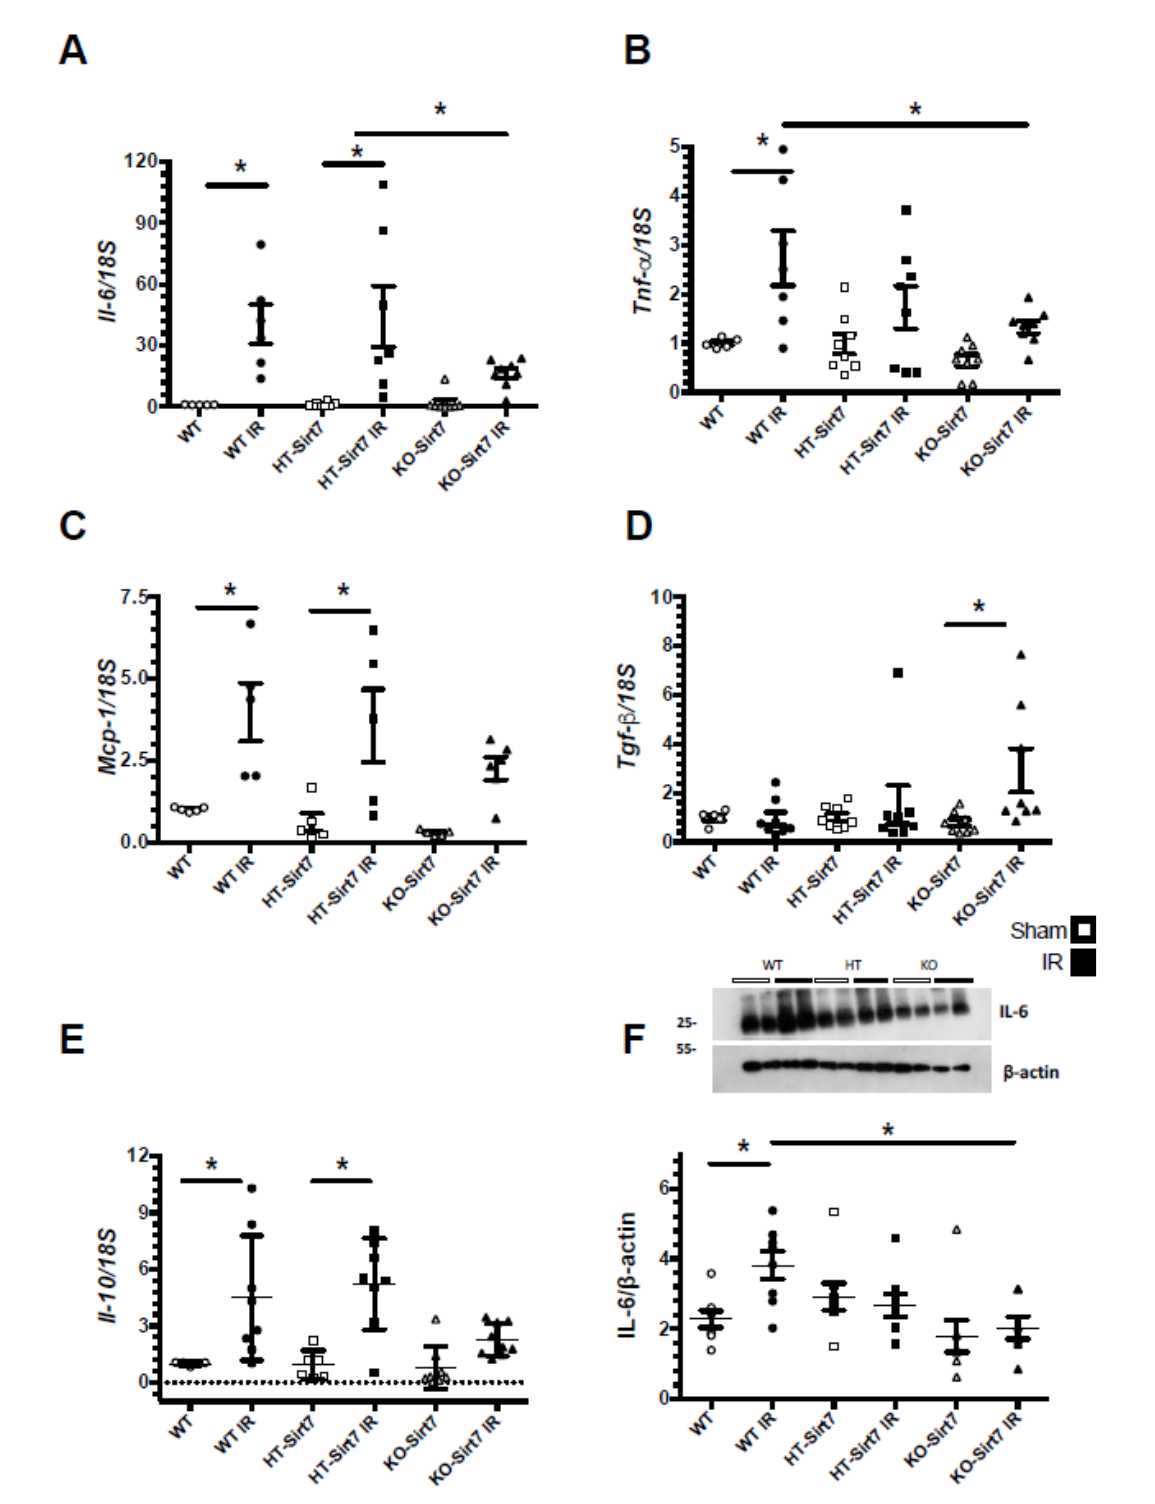
Figure 5. mRNA levels of inflammatory cytokines. ( A ) Il6 , ( B ) Tnfa . ( C ) Mcp1 , ( D ) Tgfb , and ( E ) Il10 mRNA levels, while in ( F ) are IL-6 protein levels. White circles represented WT, Black circles, WT+IR, White squares, HT-Sirt7, Black squares, HT-Sirt7+IR, White triangles, KO-Sirt7, and Black triangles, KO-Sirt7+IR. n = 5 – 10 per group. * p < 0.05 vs. respective group marked.